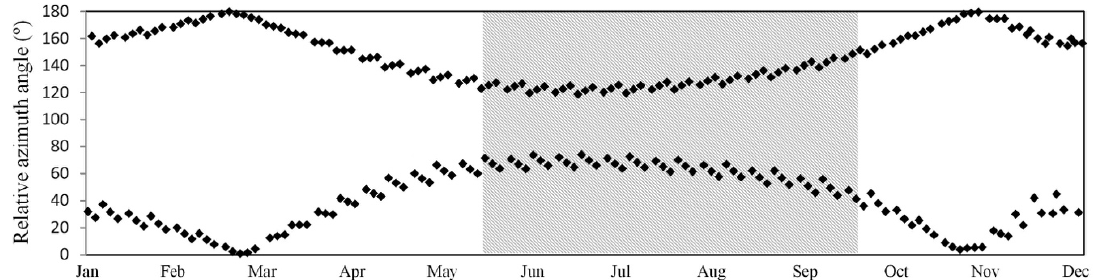
Figure 3. Daily variations in relative azimuth angle (RAA) for MODIS overpasses in Manaus (site 2), showing shifts in satellite observations toward the principal plane from the beginning to the end of the 2008 dry season (shaded area). Observations close to 180 ◦ in September to October represent the bidirectional reflectance distribution function (BRDF) hotspot direction, which produces a reflectance increase in all MODIS bands, especially in the near infrared (NIR).